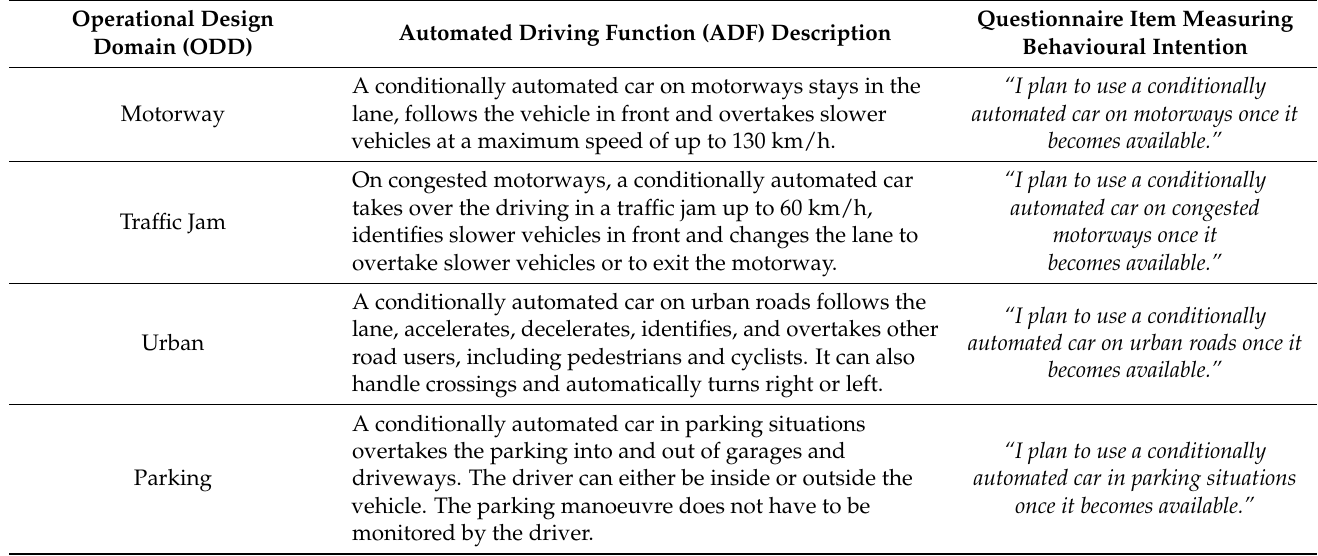
Table 1. System descriptions for Automated Driving Functions (ADFs) in motorways, traffic jams, urban areas, and parking settings.